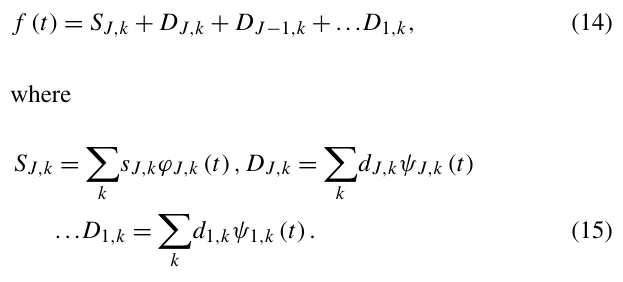
Figure 2. Scheme of multi-scale decomposition of signals us- ing maximum overlap discrete wavelet transformation (MODWT). The relationship between signal Y t (blue), detailed component D j (black), and approximate component S j (red) is